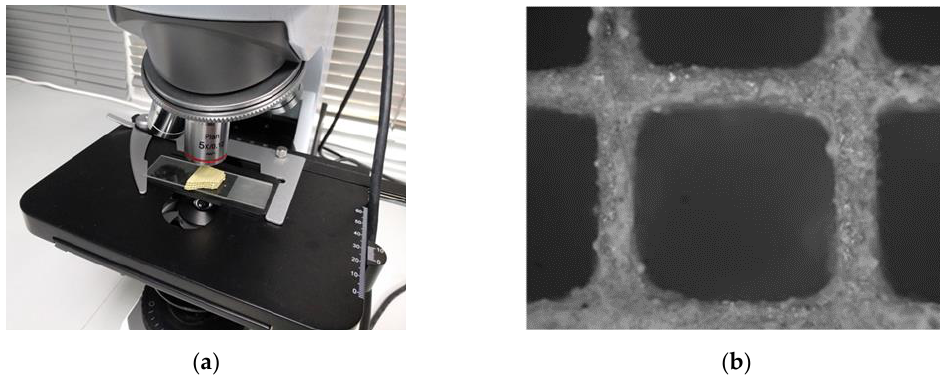
Figure 15. ( a ) Optical microscope used to estimate the thickness and morphology of the washcoat in TWCs; ( b ) optical microscopy cross-section images of the 15 g/ft 3 Prometheus monolithic catalyst.